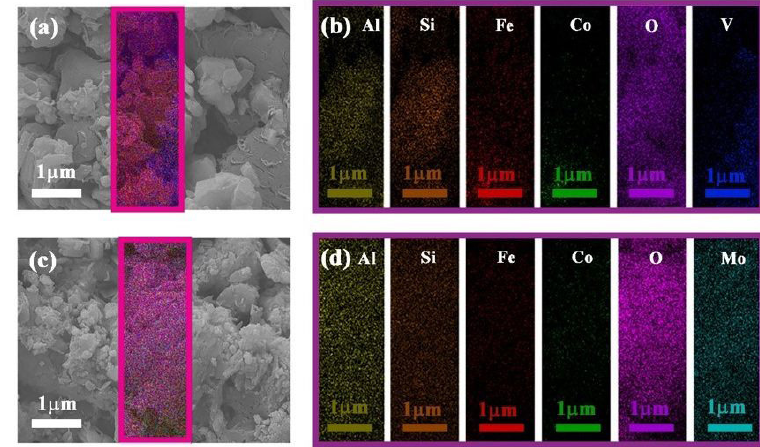
Figure 4. (a, c) FESEM map images and (b, d) the corresponding elemental mappings for (a, b) Fe-Co-V/Zeolite and (c, d) Fe-Co-Mo/ Zeolite CNs.